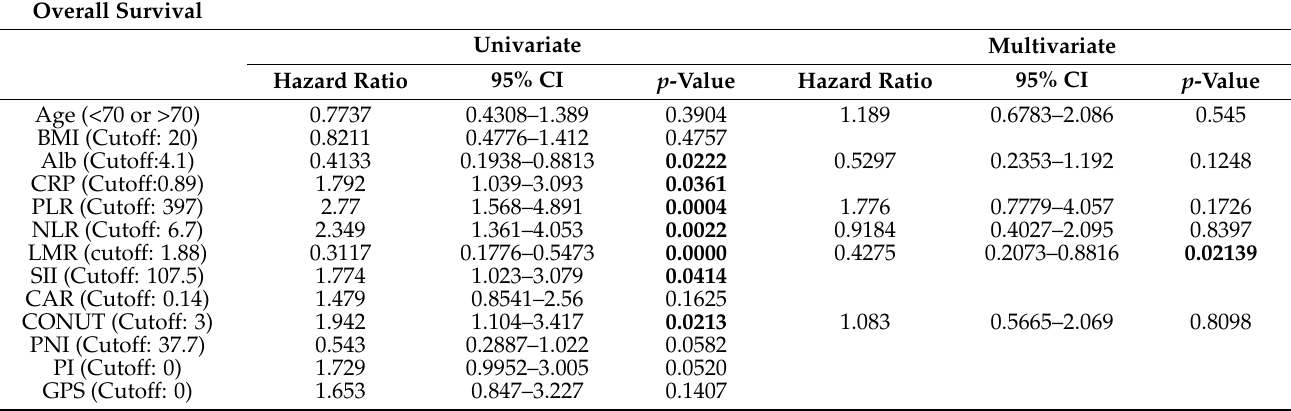
Table 4. Cox regression analysis for correlation of nutritional and inflammatory biomarkers associated with overall survival and progression-free